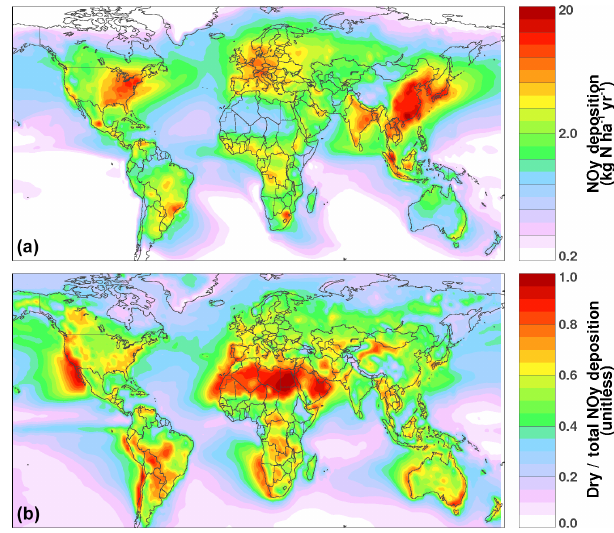
Figure 1. Long-term (1996–2014) mean NO y deposition derived from the GEOS-Chem simulation, constrained by satellite obser- vations of NO 2 columns from the GOME, SCIAMACHY, and GOME-2 instruments (a) . Mean ratio of simulated dry NO y depo- sition to total NO y deposition (b)